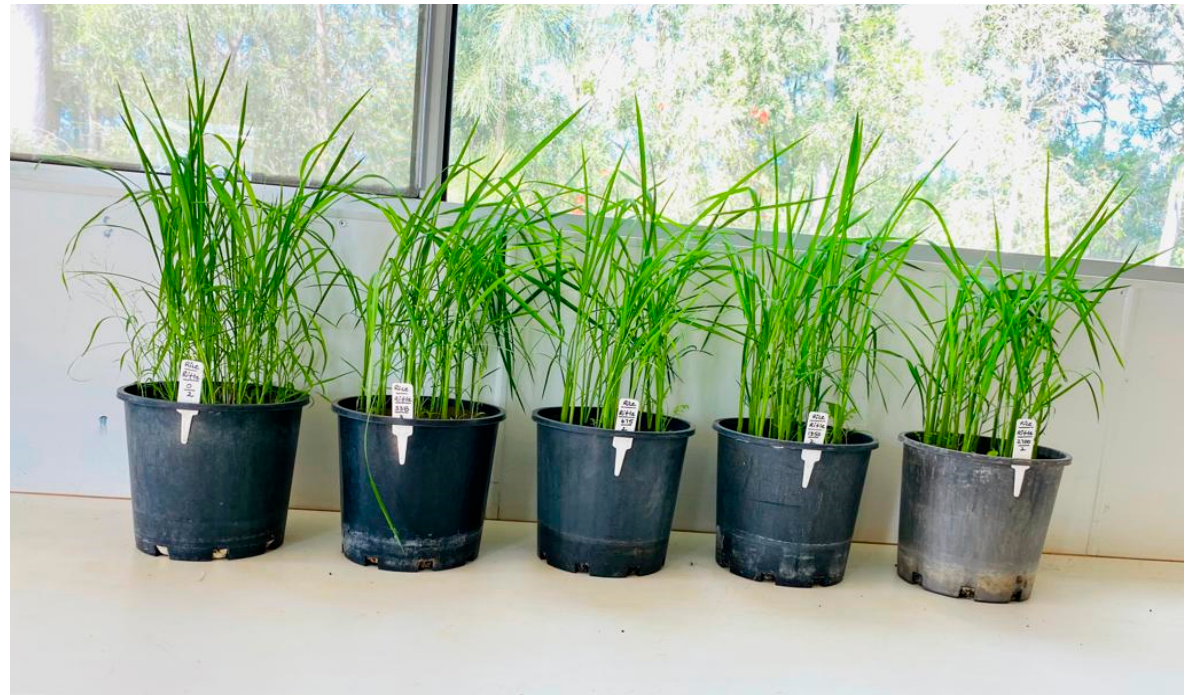
Figure 3. Echinochloa colona seedlings in response to pendimethalin doses (Left to Right: Pendime ‐ thalin doses are in increasing order: 0, 149, 298, 596, and 1192 g ai ha − 1 .